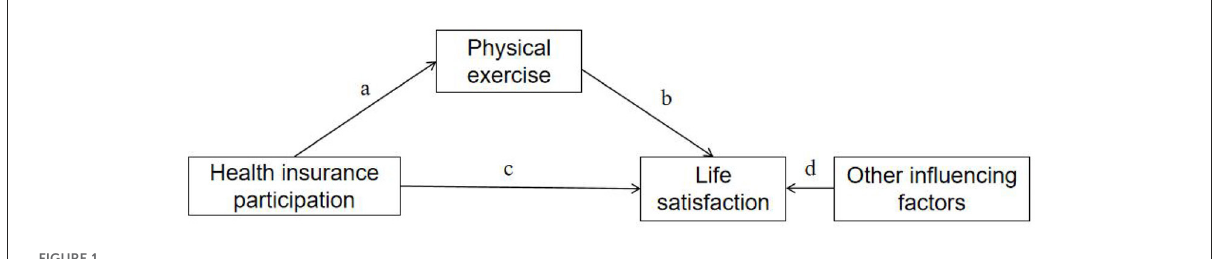
FIGURE1 Theoretical assumptions